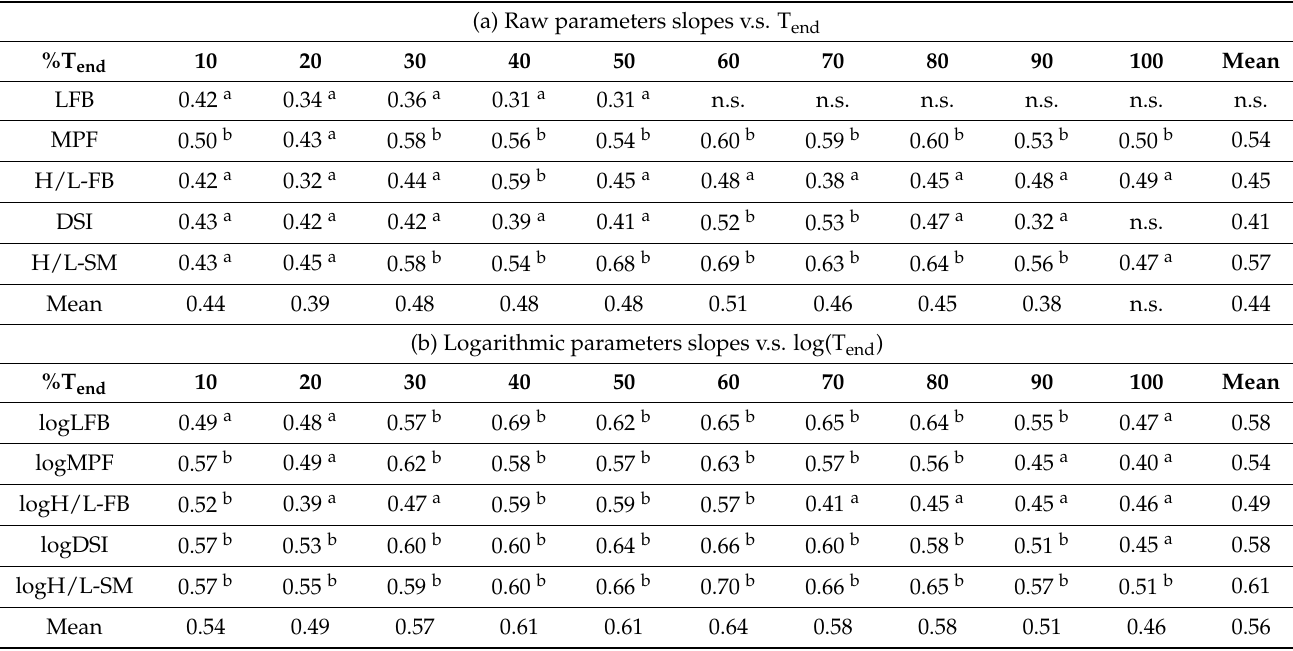
Table 6. Correlation coefficients between the endurance times and slopes as predictors estimated over the time periods of every 10% of T end